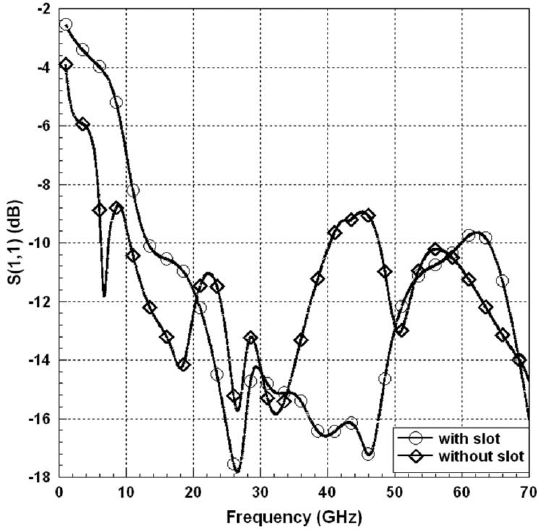
Figure 9. Comparison of S-parameters with and without rectangular slot.